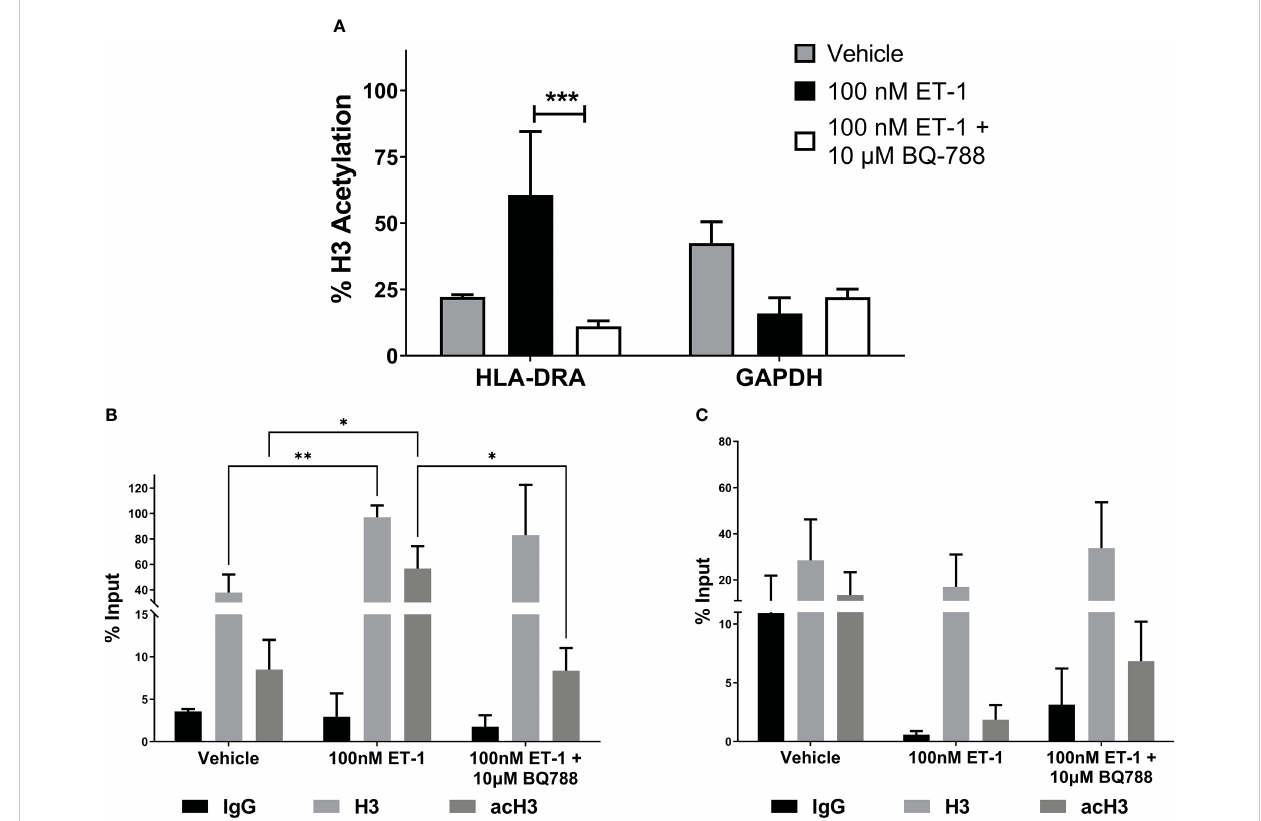
FIGURE 3 ET-1 induces histone H3 acetylation in MHC class II promoter. EA.hy926 cells were treated with 100 nM ET-1 and 100 nM ET-1 + 10 µM BQ-788 for 24 hours at 37°C. (A) Lysates were immunoprecipitated with antibodies against histone H3 and acetyl-K9 histone H3. DNA was isolated and analyzed via real-time PCR. Values were normalized to the total amount of promoter DNA added to the reaction (input). Input = 5% of total cell lysate. ***p < 0.001 versus preincubation with BQ-788. (B) H3 and acetylated H3 (acH3) chromatin immunoprecipitation for HLA-DRA promoter. (C) H3 and